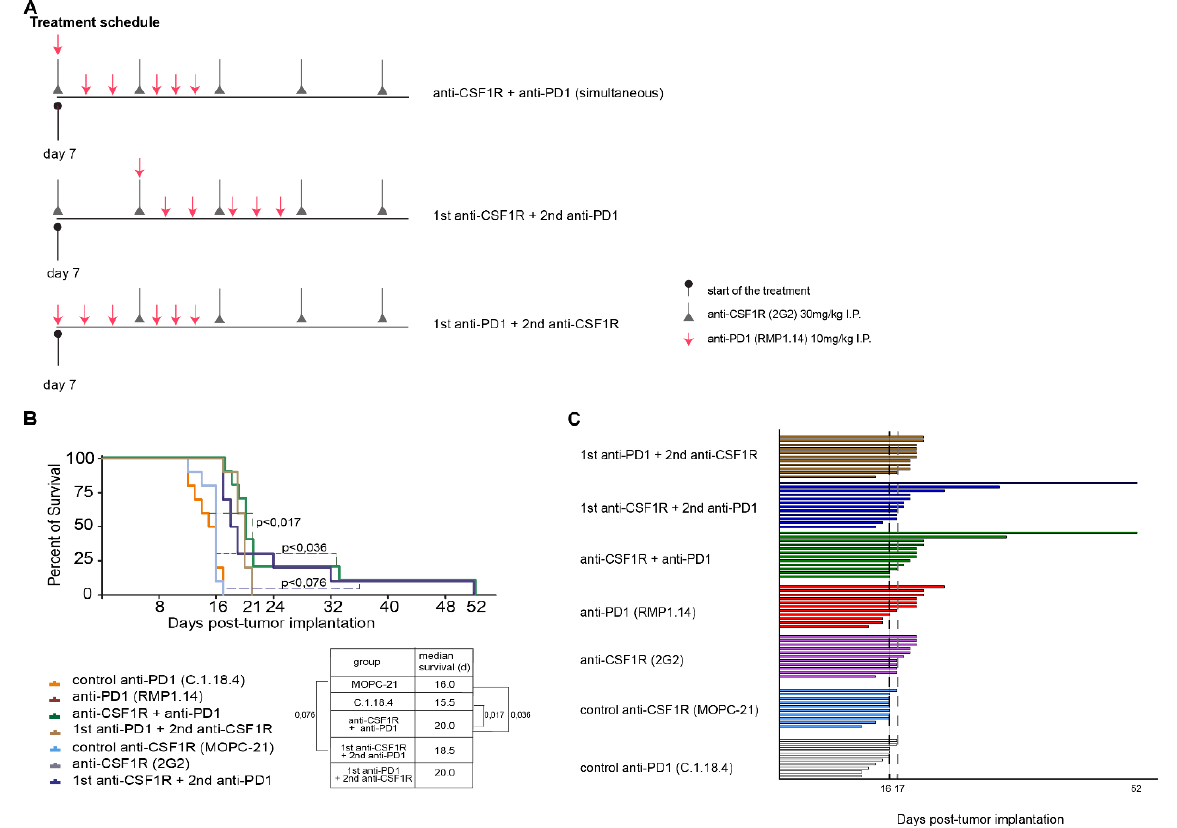
Figure 3. Simultaneous and sequential combinations of PD1 and CSF1R blockade in vivo. ( A ): Schematic overview of experimental design. ( B ): Kaplan–Meier plots: combination therapies vs. monotherapies vs. controls. Experimental groups ( n = 10 in each group) are as indicated: Blue dashed line shows p -value between combination therapy group starting with anti-CSF1R treatment and CSF1R control group. Green dashed lines show p -value between both control groups vs. simultaneous combination group. P-values were calculated by using Tukey–Kramer post hoc test after performing Log-rank (Mantel–Cox) test ( p < 0.0001). ( C ): Symptom-free survival graph displaying each single mouse per experimental group. Experimental groups are: control anti-PD1, control anti-CSF1R, anti-PD1, anti-CSF1R, anti-CSF1R plus anti-PD1, anti-CSF1R and then anti-PD1, and anti-PD1 and then 2nd anti-CSF1R. Dashed line on day 16 represents median latency until experimental endpoint in control group. Dashed line on day 17 shows time point where last animal of control group reached experimental endpoint. Day 52 indicates last surviving animals. Experimental endpoints are described in detail in the material/methods section and in Supplementary Table